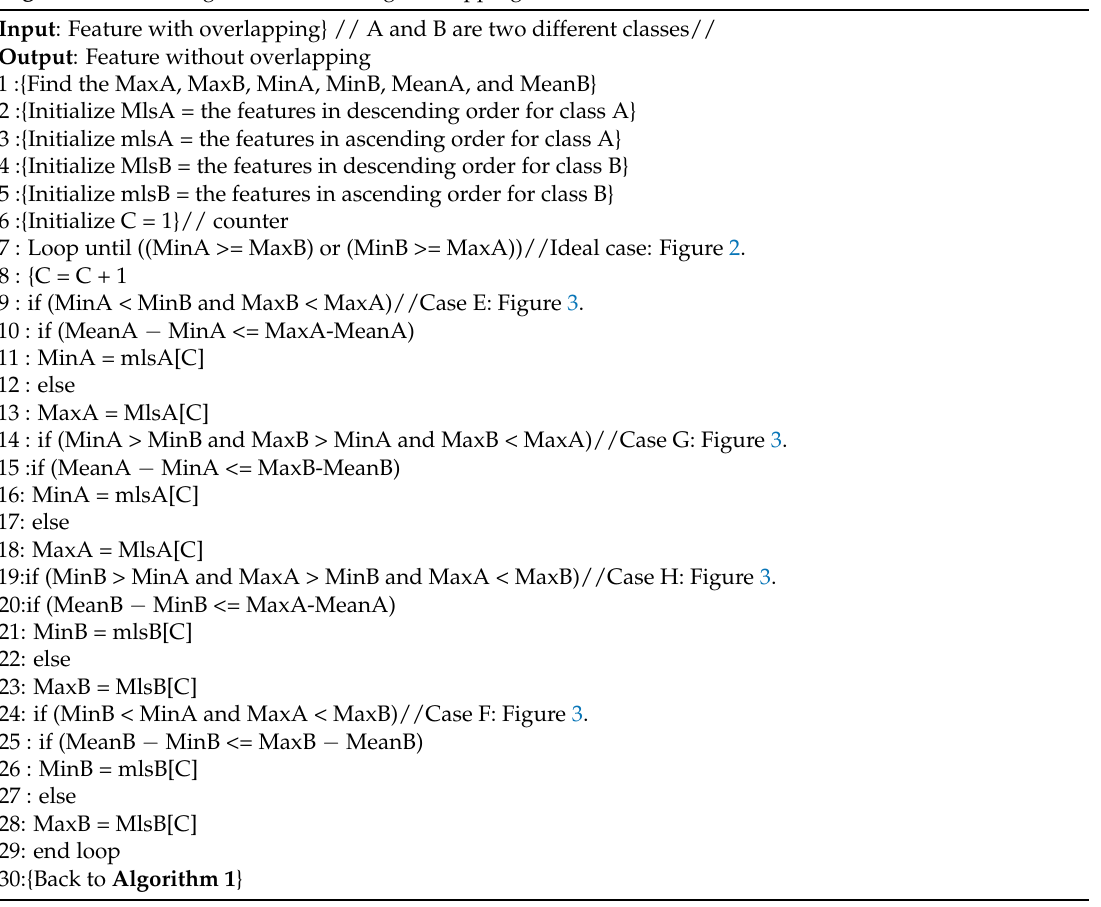
Algorithm 2 is the algorithm for solving